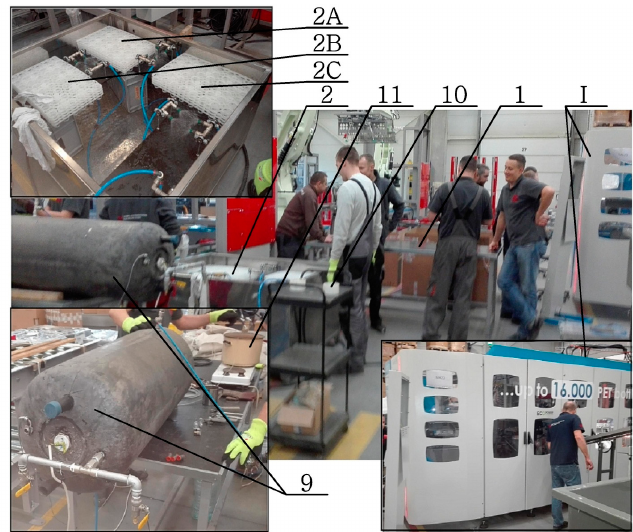
Figure 2. Measuring station for filling, annealing, and cooling of manufactured bottles (the numbering shown in the figure refers to the numbering shown in Figure 1 and Table 1).